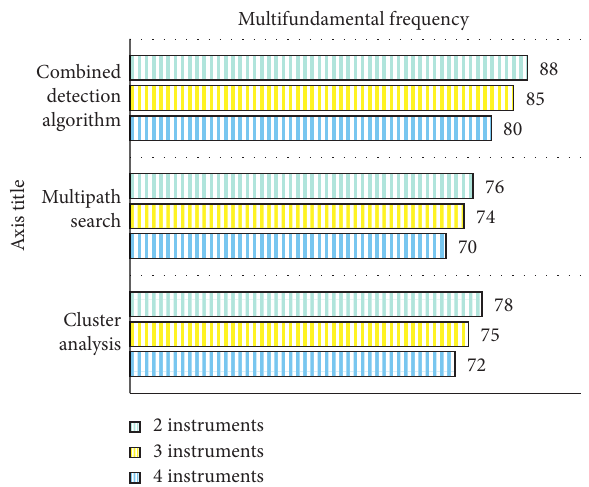
Figure 5: Comparison of experimental results before and after the improvement of the multifundamental frequency estimation algorithm.